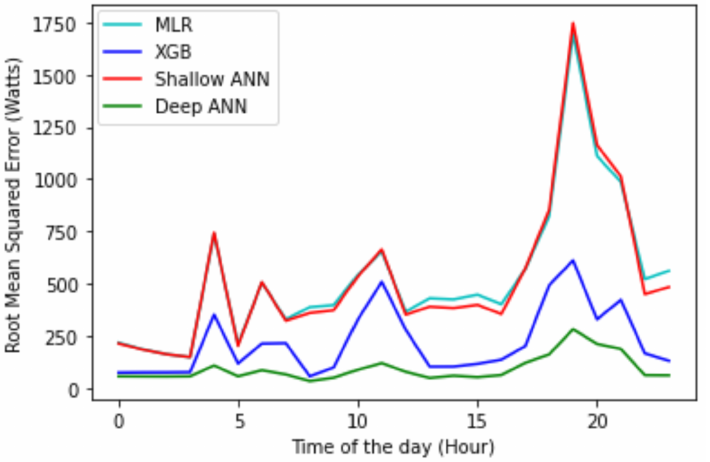
Figure 9. The graph of RMSE of estimated energy consumption value using MLR (cyan), XGBoost (blue), shallow ANN (red), and deep ANN